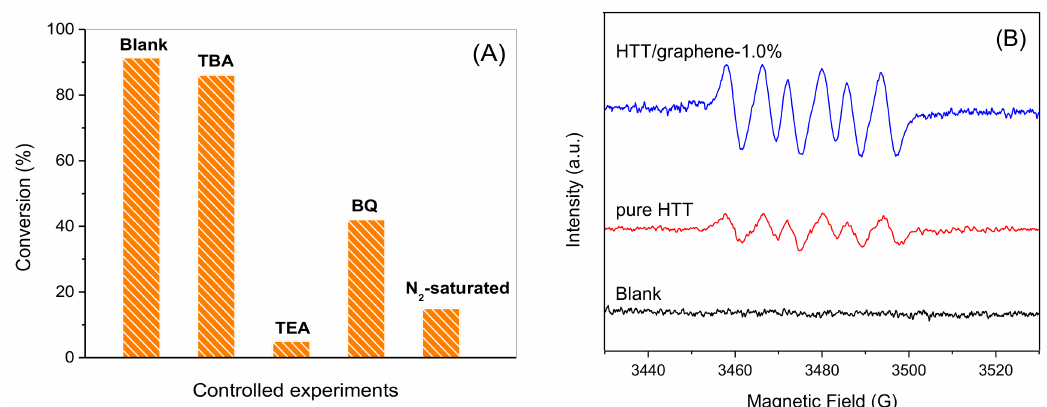
Figure 12. ( A ) Control experiments of photocatalytic selective oxidation of benzyl alcohol in the presence of various scavengers or in the absence of O 2 over HTT/graphene-1.0% under visible light irradiation for 6 h. ( B ) Electron spin resonance (ESR) spectra of O 2 · – trapped by DMPO over pure HTT and HTT/graphene-1.0% suspensions in methanol solution, blank represents both the sample containing DMPO alone under light illumination and the sample containing DMPO and catalysts in